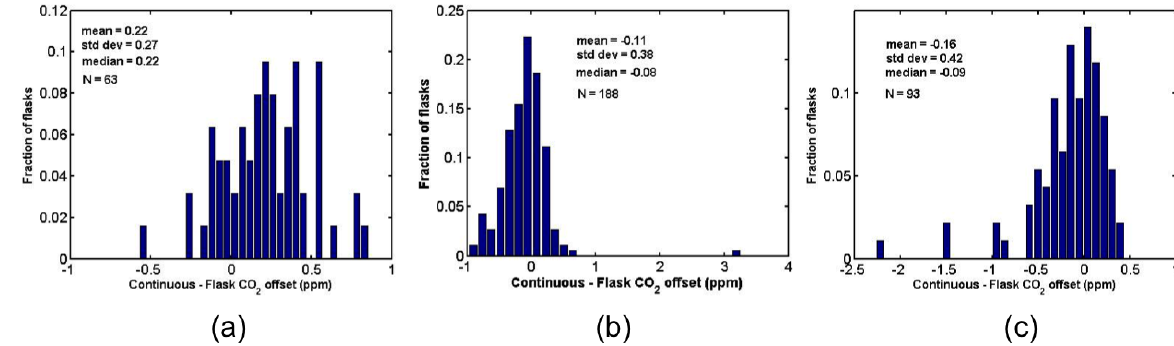
Fig. 9. Differences between continuous (CRDS) CO 2 measurements and flask CO 2 measurements during flights over Alaska on the USCG C-130 for three seasons: (a) 2009, (b) 2010, and (c) 2011. Negative offsets occur when the flask-measured mole fraction is higher than the continuous measurement. The mean for each season, 1- σ standard deviation, and number of flasks for comparison are indicated on each figure.